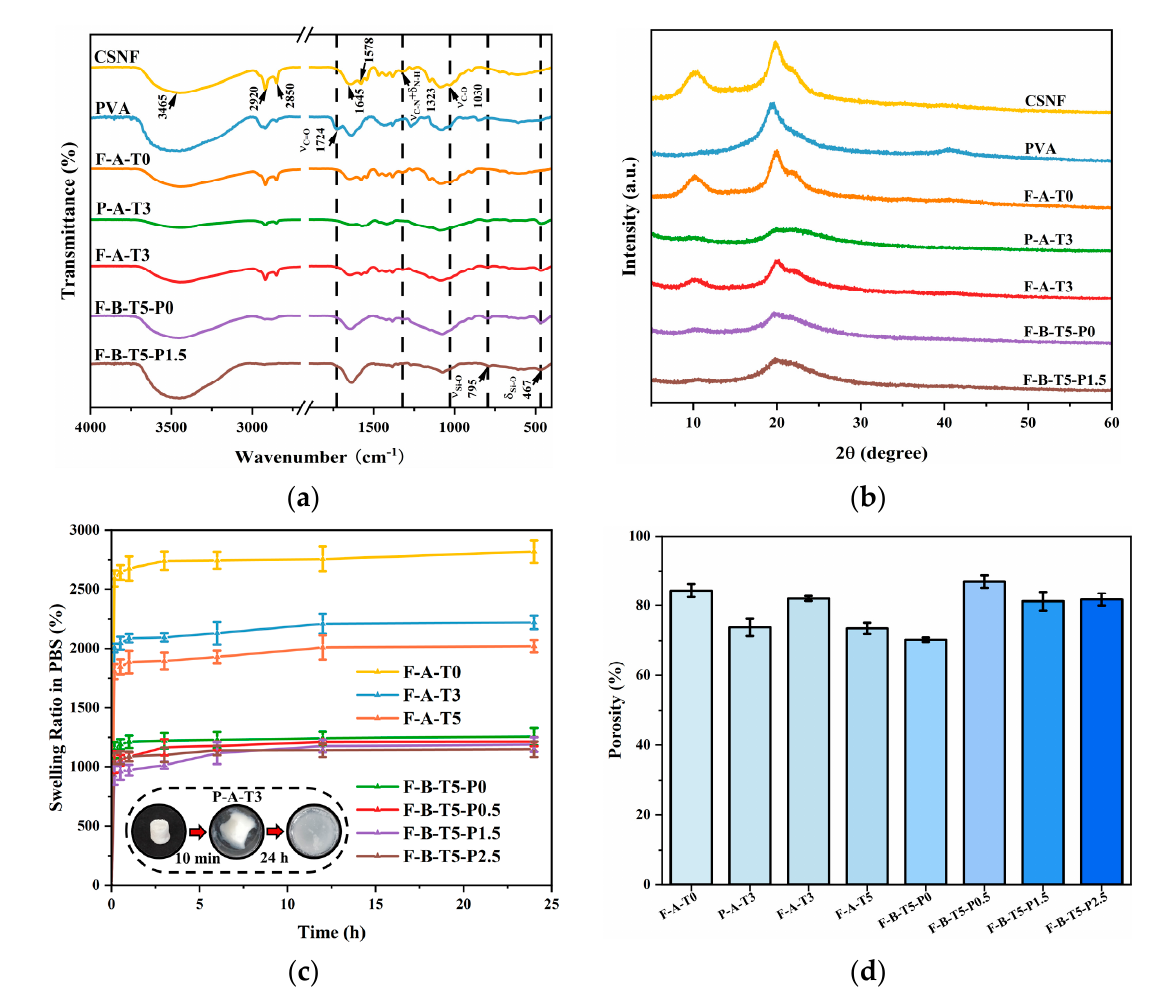
Figure 4. ( a ) FT ‐ IR and ( b ) XRD of CSNF, PVA, F ‐ A ‐ T0/T3, P ‐ A ‐ T3, and F ‐ B ‐ T5 ‐ P0/P1.5. ( c ) swelling Figure 4. ( a ) FT-IR and ( b ) XRD of CSNF, PVA, F-A-T0/T3, P-A-T3, and F-B-T5-P0/P1.5. ( c ) swelling ration and ( d ) porosity of scaffolds. ration and ( d ) porosity of